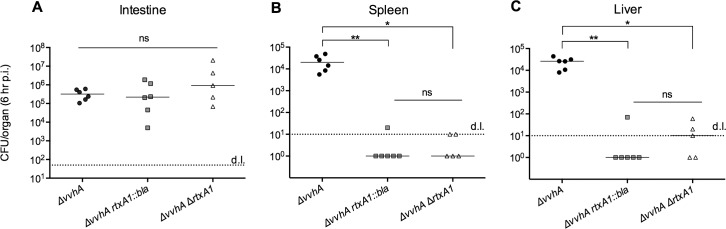
MARTX toxin effector domains are required for bacterial dissemination from intestine to distal organs.Live rifampin-resistant V. vulnificus recovered by plating of tissue homogenates of the (A) whole intestine, (B) spleen, and (C) liver at 6 hr p.i. for 5–6 mice per group. Plot symbols represent CFU/organ for individual mice, lines indicate mean, with statistical significance determined by one-way ANOVA followed by multiple comparison’s test to determine p values. *p<0.05, **p<0.01, ***p<0.001, n.s. = not significant, d.l. = detection limit.